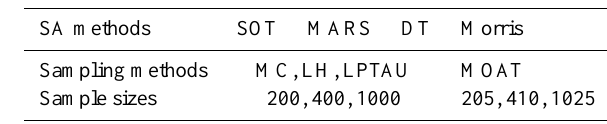
Table 6. The experiment designs to confirm the proper sampling methods and sample size for SA